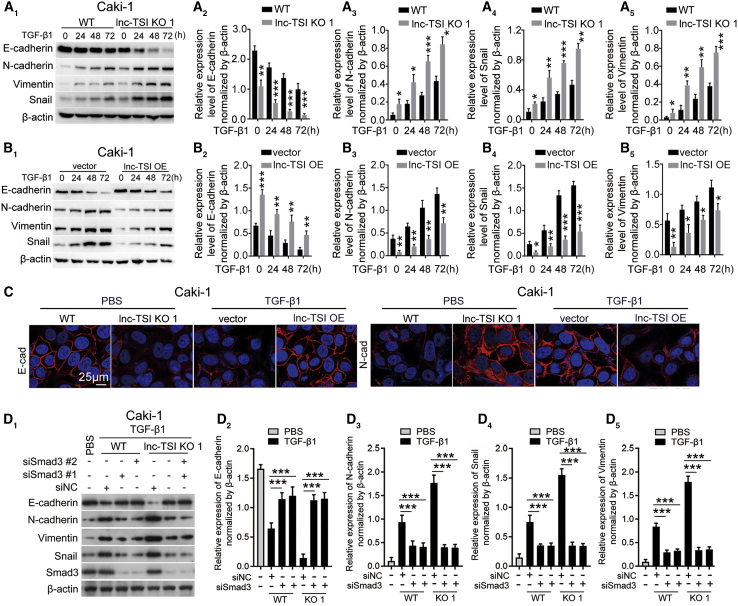
lnc-TSI Inhibited TGF-β1-Induced Epithelial-Mesenchymal Transition in Caki-1 Cells(A) Representative western blot and quantitative data showed that knockout of lnc-TSI increased the expression of N-cadherin, Vimentin, and Snail and decreased the expression of E-cadherin. (B) Representative western blot and quantitative data showed that overexpression of lnc-TSI in Caki-1 cells decreased the expression of N-cadherin, Vimentin, and Snail and increased the expression of E-cadherin. (C) Immunofluorescence staining for E-cadherin and N-cadherin. (D) Representative western blot and quantitative data showed that knocking down Smad3 reversed the effects of lnc-TSI knockout. Data are expressed as means ± SD of three independent experiments. ∗p < 0.05, ∗∗p < 0.01, ∗∗∗p < 0.001.